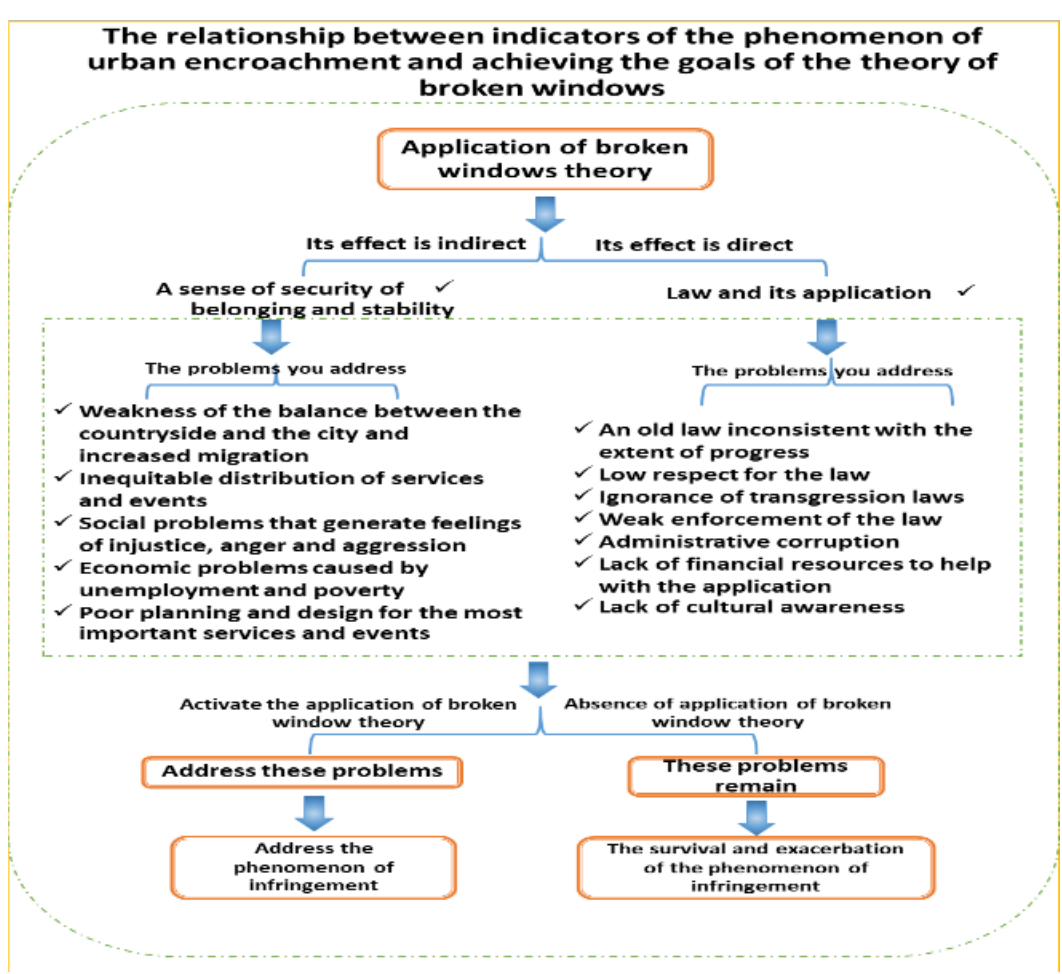
Fig. 1. The relationship between indicators of the phenomenon of urban encroachment / source: the researcher based on previous